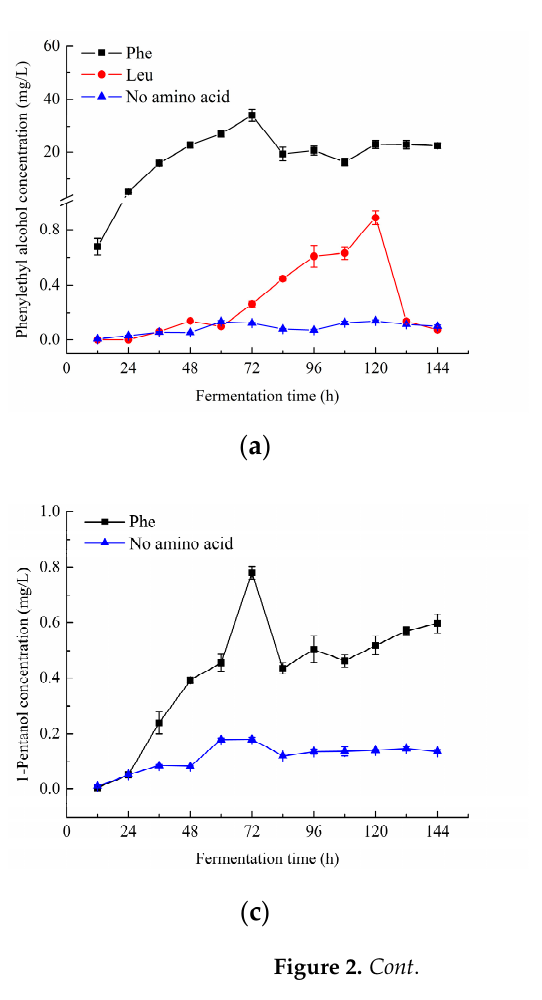
Figure 1. Changes in glucose ( a ) and pyruvic acid ( b ) of the simulated juice system with the addition of L-Leucine ( ) and L-phenylalanine ( ), respectively, during fermentation.